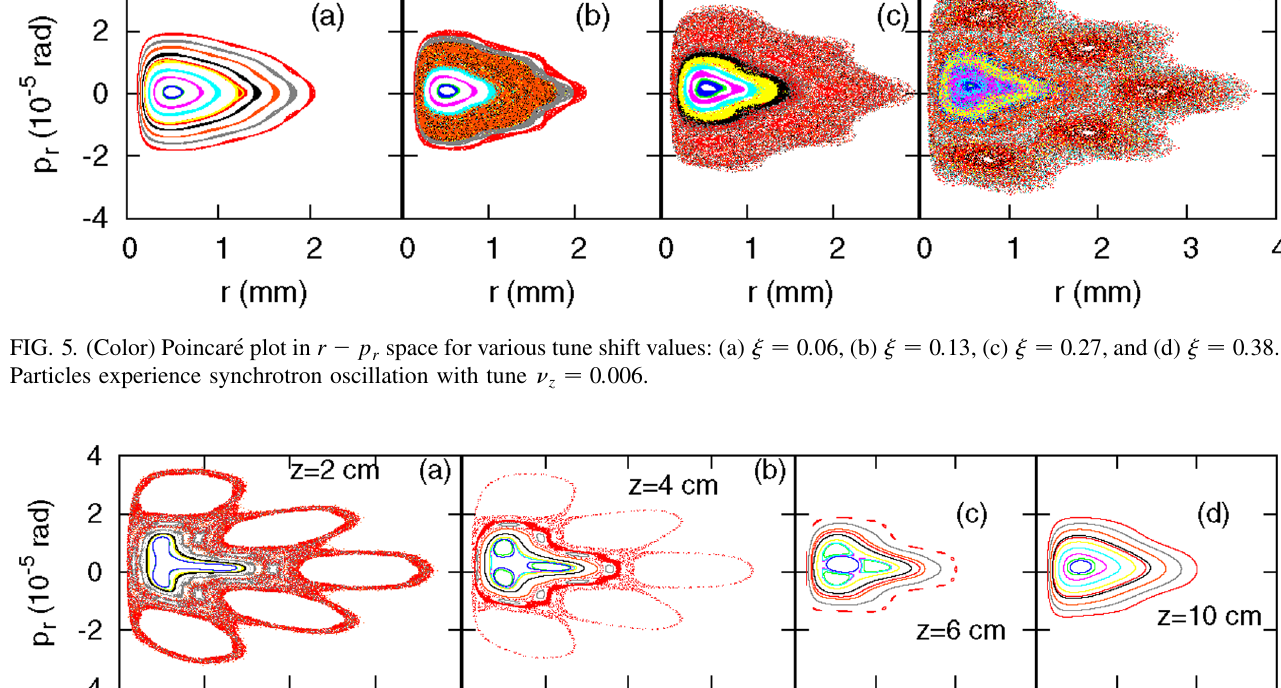
for z (cid:5) 2 ; 4 ; 6 ; 10 mm ( (cid:12) (cid:5) 0 : 38 r